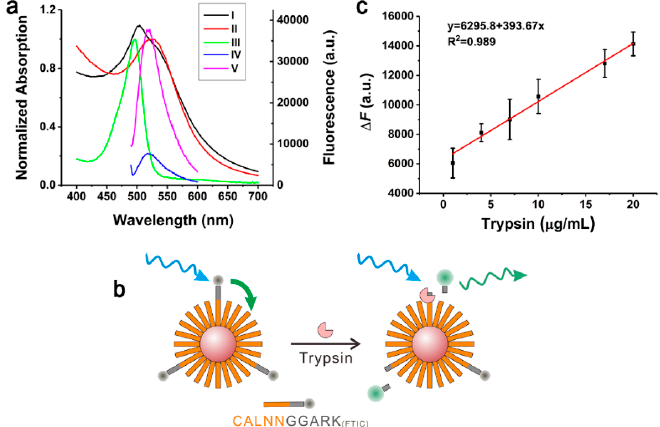
Figure 6. ( a ) Normalized UV–vis absorption spectra of (I) functional AuNPs that labeled with FITC, (II) CALNN-coated AuNPs, (III) FITC, and the (IV) fluorescence spectra of functional AuNPs without and (V) with trypsin. ( b ) Scheme of the fluorescence-based trypsin detection with functional AuNPs. ( c ) The standard curve for trypsin detection with functional AuNPs.